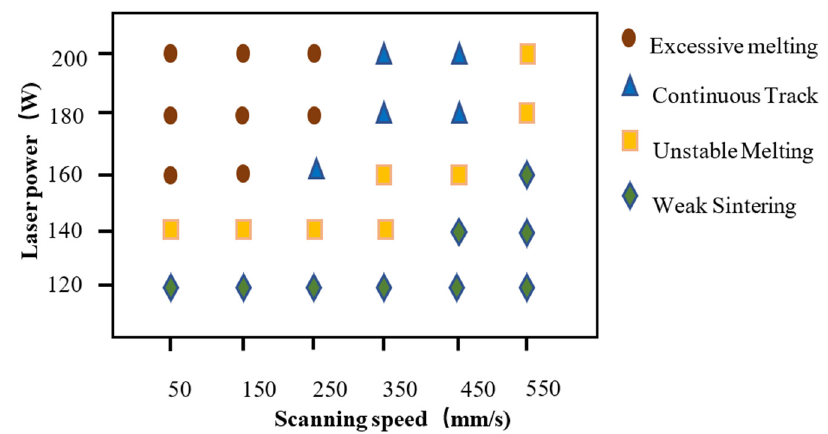
Figure 5. The melt track of the as-built Mo SLM parts under different zone: ( a ) zone A, LED = 0.36 J/mm, ( b ) zone B, LED = 0.64 J/mm, ( c ) zone C, LED = 0.51 J/mm, overlap = 20%, ( d ) zone D, LED =